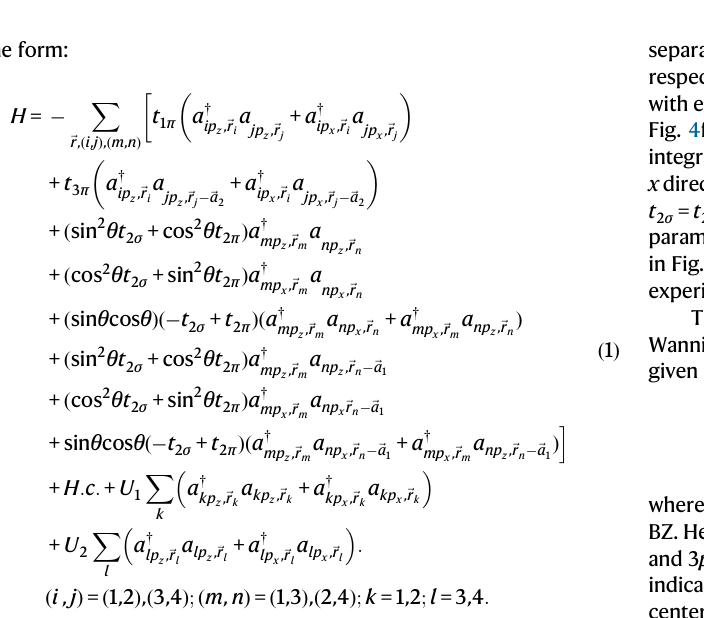
Fig. 4 | Theoretical calculation results of Si/Ag(001). a DFT calculated band structure of Si/Ag(001) along the (cid:1) M (cid:1) (cid:1) X (cid:1) (cid:1) M direction of Ag(001). b – e DFT cal- culatedbandstructuresforcomparisonwithARPESspectraalongCuts1-4inFig.3. ThecalculatedbandstructuresareprojectedontotheSiandtopmostAglayer.Blue dashedlinesareguidestotheeyeforcomparisonwithARPESmeasurementresults. The marker size and color represent the spectral weight that comes from the projectionofthesupercellwavefunctiontotheBZoftheprimitivecell. f Schematic